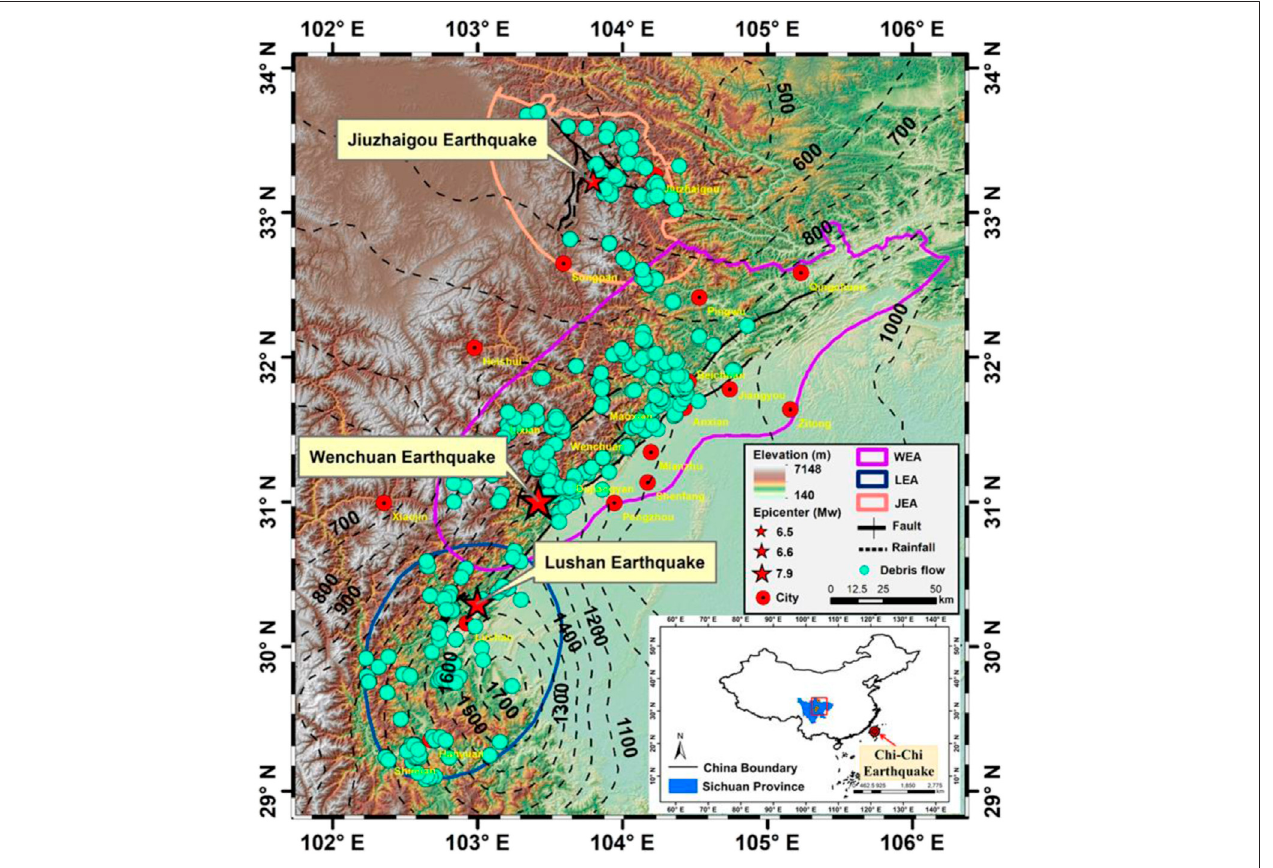
FIGURE 1 | Location of study areas in Sichuan Province, China. The ranges, elevations, main faults, debris- fl ow records ( fi lled dot), epicenters (pentagram), momentmagnitude(Mw),andmeanannualrainfall(contourwith100 mminterval)areshownfortheWEA(Chineseseismicintensity ≥ VIII),LEA(Chineseseismicintensity ≥ VI), and JEA (Chinese seismic intensity ≥ VI), respectively. The location of the Chi-Chi earthquake in Taiwan Province is also marked in the subplot.